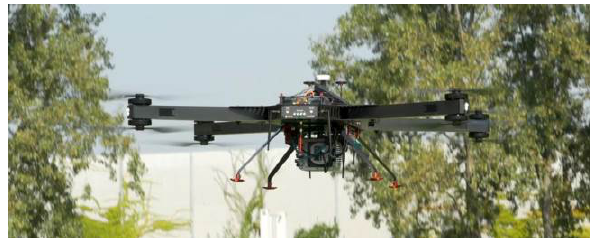
Figure 2: RIEGL RiCOPTER-M during test flight